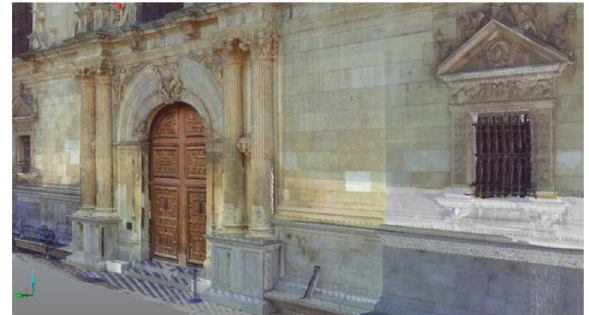
Figure 11: Model detail of the entrance zone during the work On the other hand, it is intended to put the data obtained within the INSPIRE standards. They are two main data specifications inside INSPIRE where cultural heritage data are site: Data Specification on Protected Sities, and the Data Specification on Area management / restriction / regulation zones and reporting units (Chias and Abad, 2015).